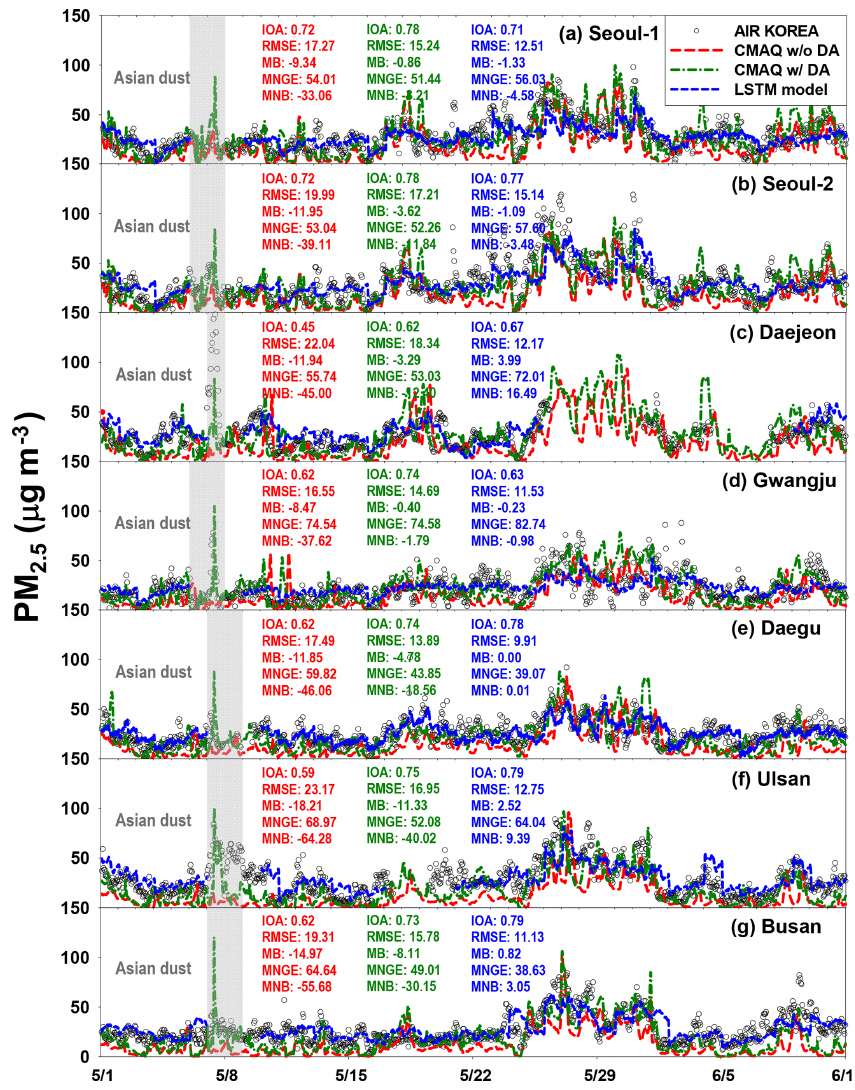
Figure 7. Same as Fig. 6 but for PM 2 . 5 .